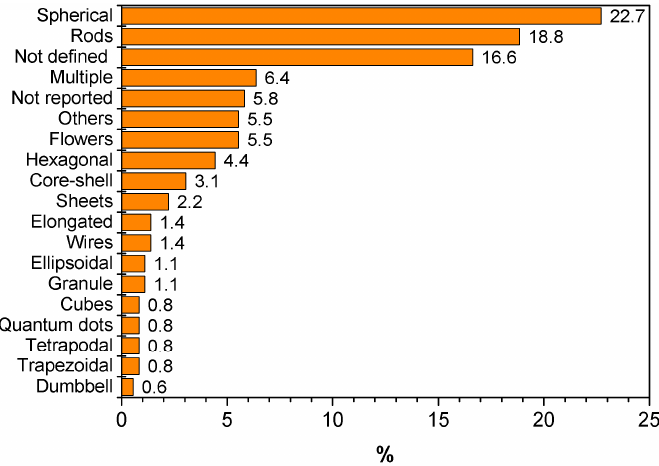
Figure 15. ZnO shapes on composites.